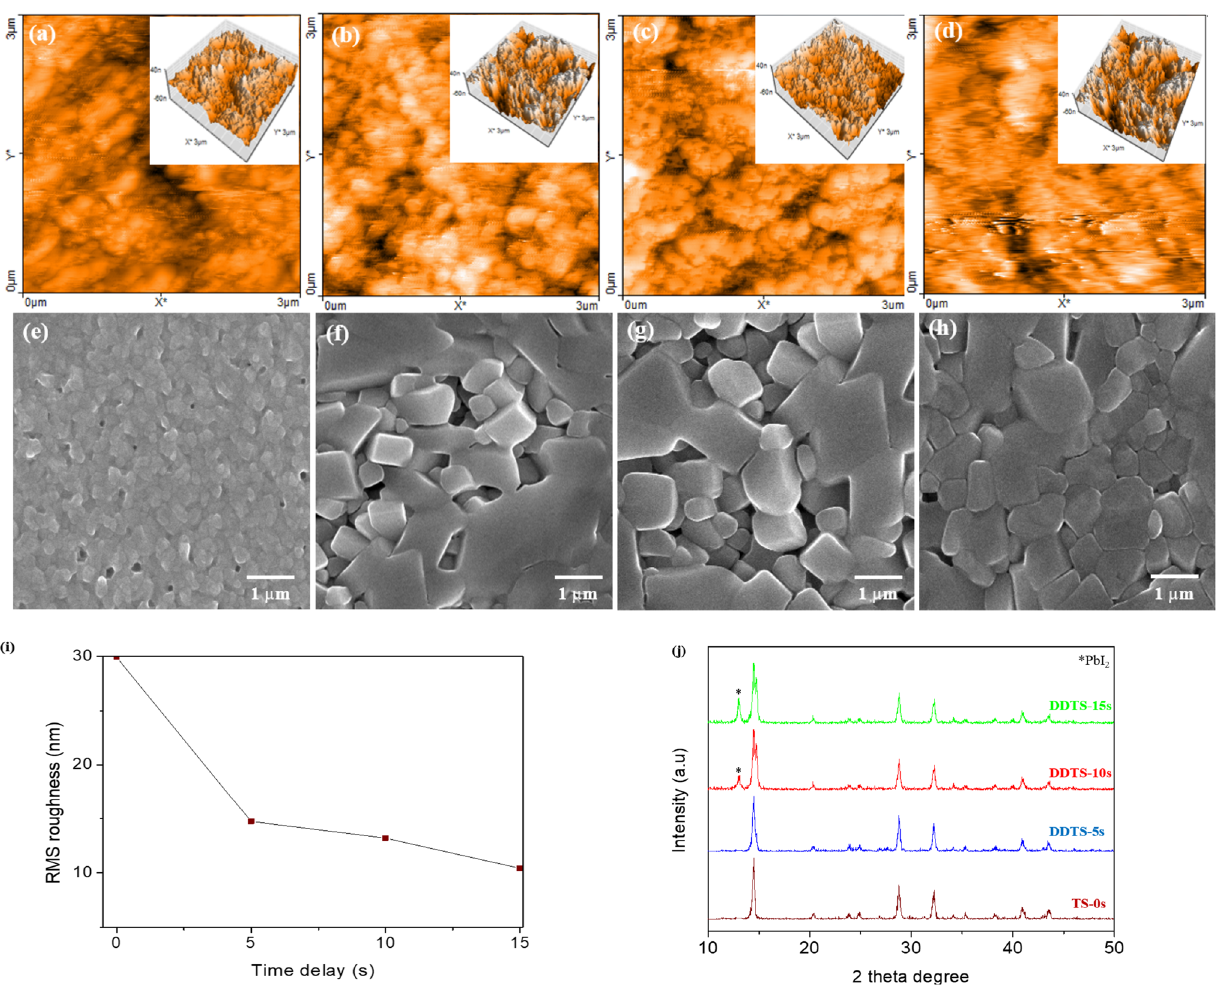
Fig. 3 a – d AFM images of TS-0s, DDTS-5s, DDTS-10s, and DDTS- 15s, respectively. e – h FESEM surface images of TS-0s, DDTS-5s, DDTS-10s, and DDTS-15s, respectively. (i) RMS roughness of